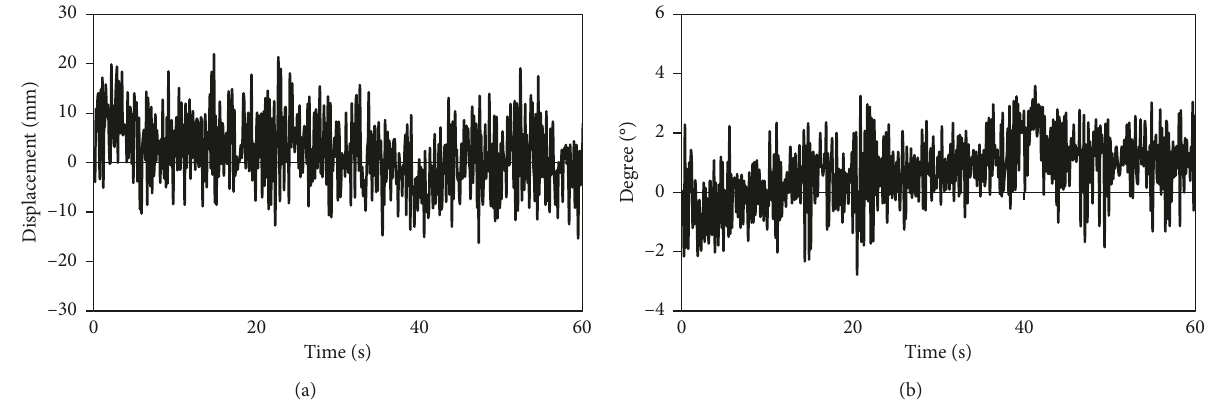
Figure 6: Time history responses for CM2, θ � 30 ° , 0.5(D), at 15m/s: (a) vertical vibration; (b) torsional vibration.